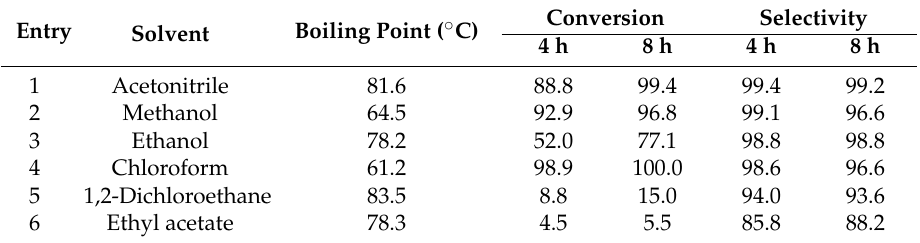
Table 4. Effect of solvents on epoxidation of